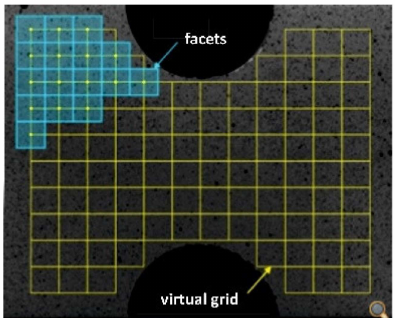
Figure 2. Facets with virtual grid.